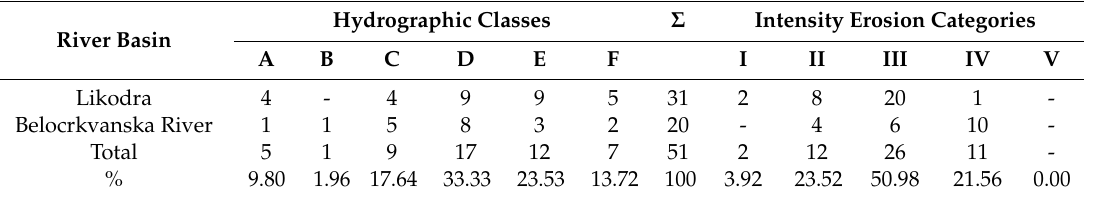
Table 4. Hydrographic classes and erosion strength categories of torrents in the Likodra river basin (in %).